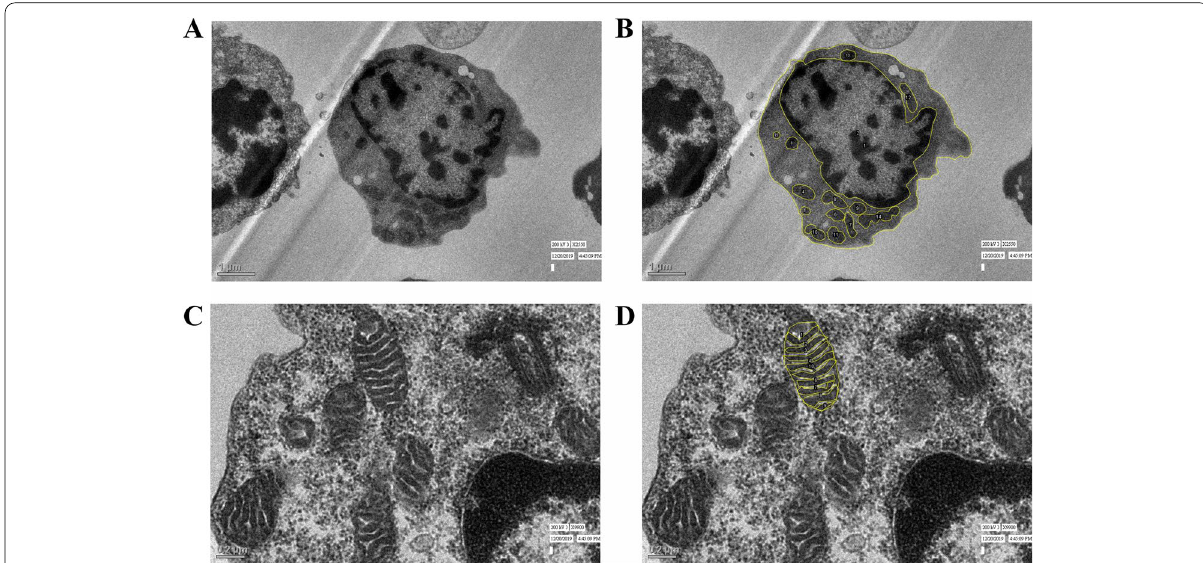
Fig. 1 Transmission electron microscopy images of lymphoblasts in bone marrow samples of ALL patients. The image analysis was done using ImageJ software after calibrating the images by the use of scales on the figure. A Representative images of electron microscopy of lymphoblast of a B-ALL patient (2250X; scale bar 1 μm). B The mitochondria have been traced using ImageJ tool for calculation of area occupied by mitochondria = in the same section mentioned in A . C Representative images of electron microscopy of mitochondria in lymphoblast of a B-ALL patient at higher magnification (9900X; scale bar 0.2 μm). D The cristae of the mitochondria have been traced using the ImageJ tool for calculation of cristae = cross-sectional area in the same section mentioned in